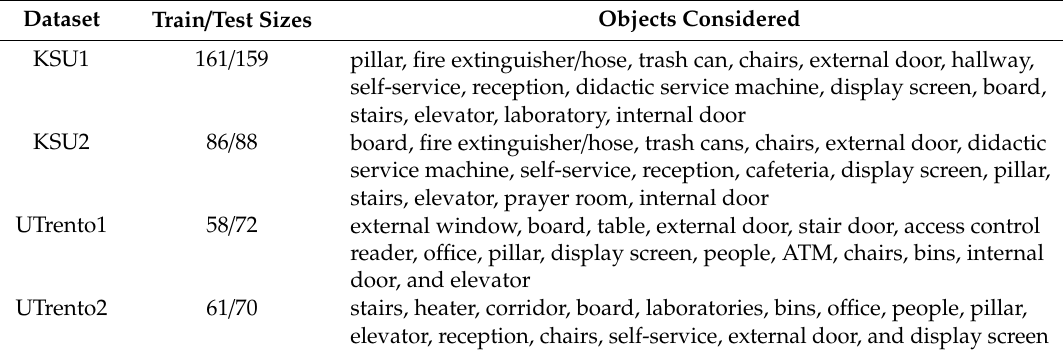
Table 1. Details of the four datasets of multi-labeled images used in the work.